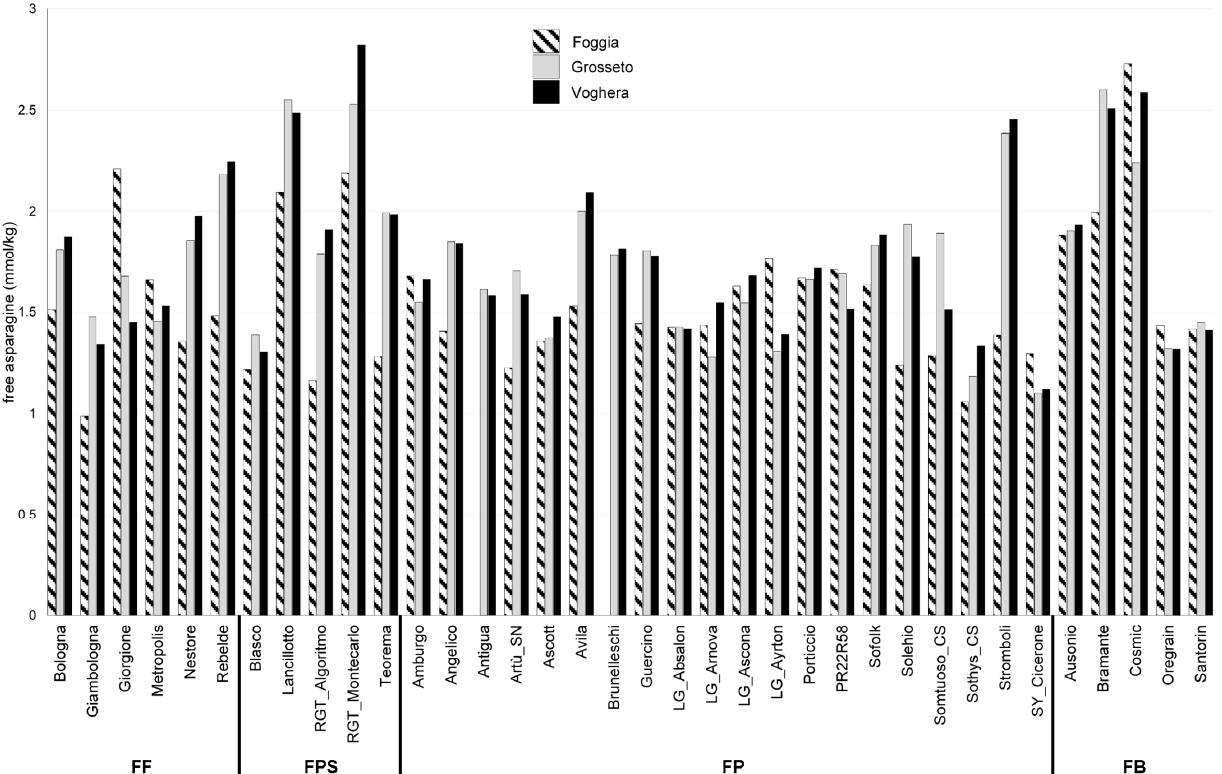
Figure 1. Concentration of fAsn in the grain of 36 bread wheat varieties grown in 2018–2019 in the three locations Foggia, Grosseto, and Voghera. FF: improver wheat; FPS: superior bread making wheat; FP: ordinary bread making wheat; FB: wheat for biscuits.